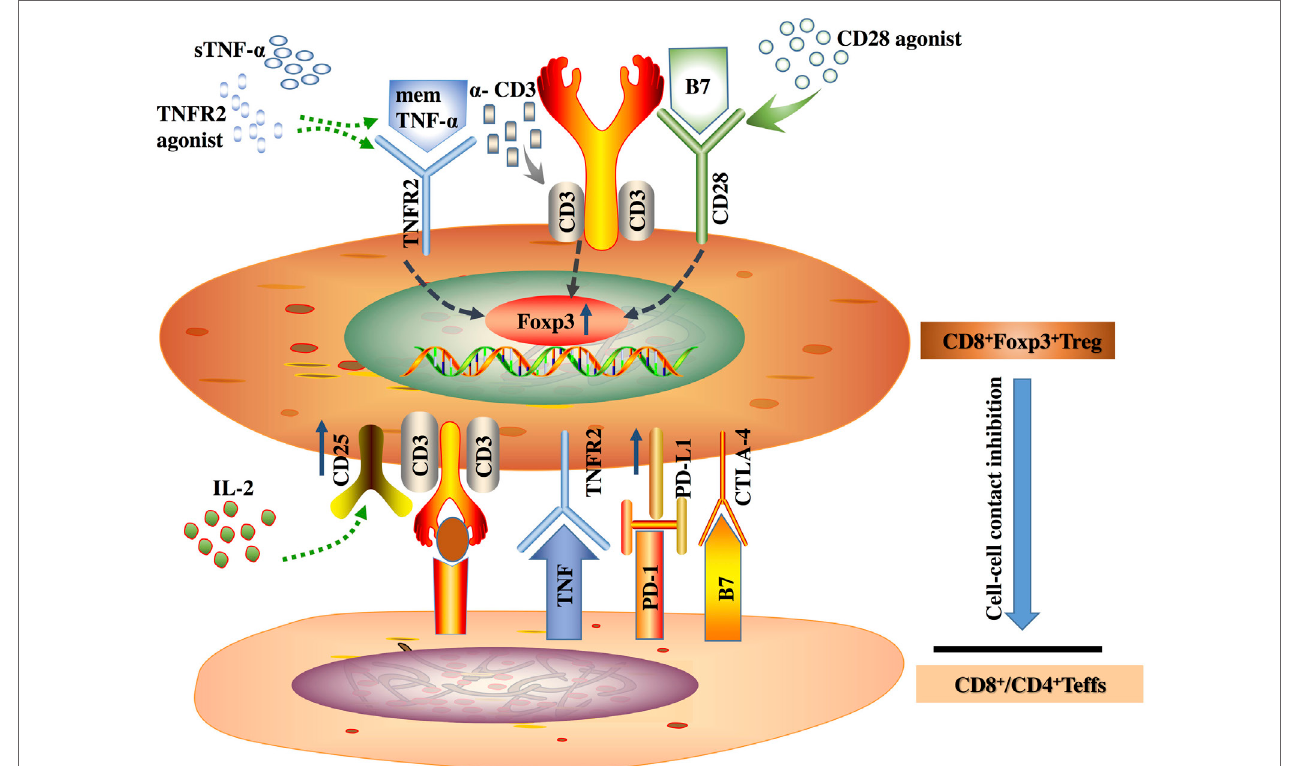
FiGURe 1 | Tumor necrosis factor (TNF) receptor type II (TNFR2) acts as a suppressive marker for CD8 + regulatory T (Tregs) cells. The TNF/TNFR2 interaction, as well as TNFR2 and CD28 agonists, could promote the induction of Foxp3 in the presence of anti-CD3. Additionally, the TNF/TNFR2 interaction could also upregulate CD25 and PD-L1, the negative molecules on the surface of CD8 + Tregs, to mediate a contact-dependent inhibition to CD4 + and CD8 + effector T cells, cooperation with other negative molecules on the surface of CD8 + Tregs, such as CTLA-4.